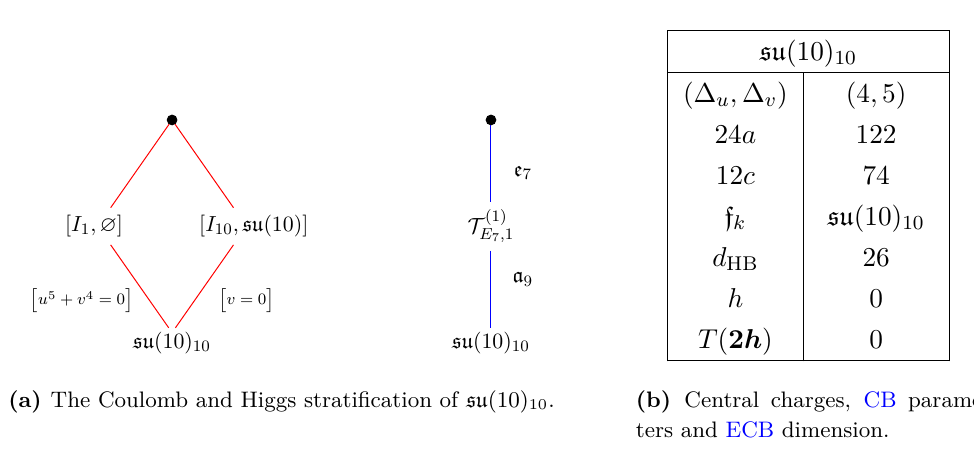
Figure 4. Information about the su (10) 10